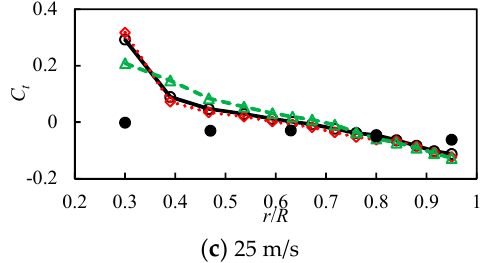
Figure 13. Comparison of the distributions of the computed tangential force coefficients at ( a ) 7 m/s, ( b ) 15 m/s, and ( c ) 25 m/s along the blade radial positions for NREL Phase VI in axial steady conditions.